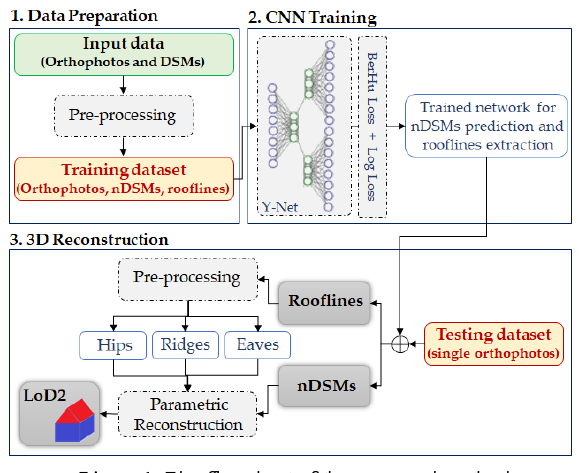
Figure 1. The flowchart of the proposed method